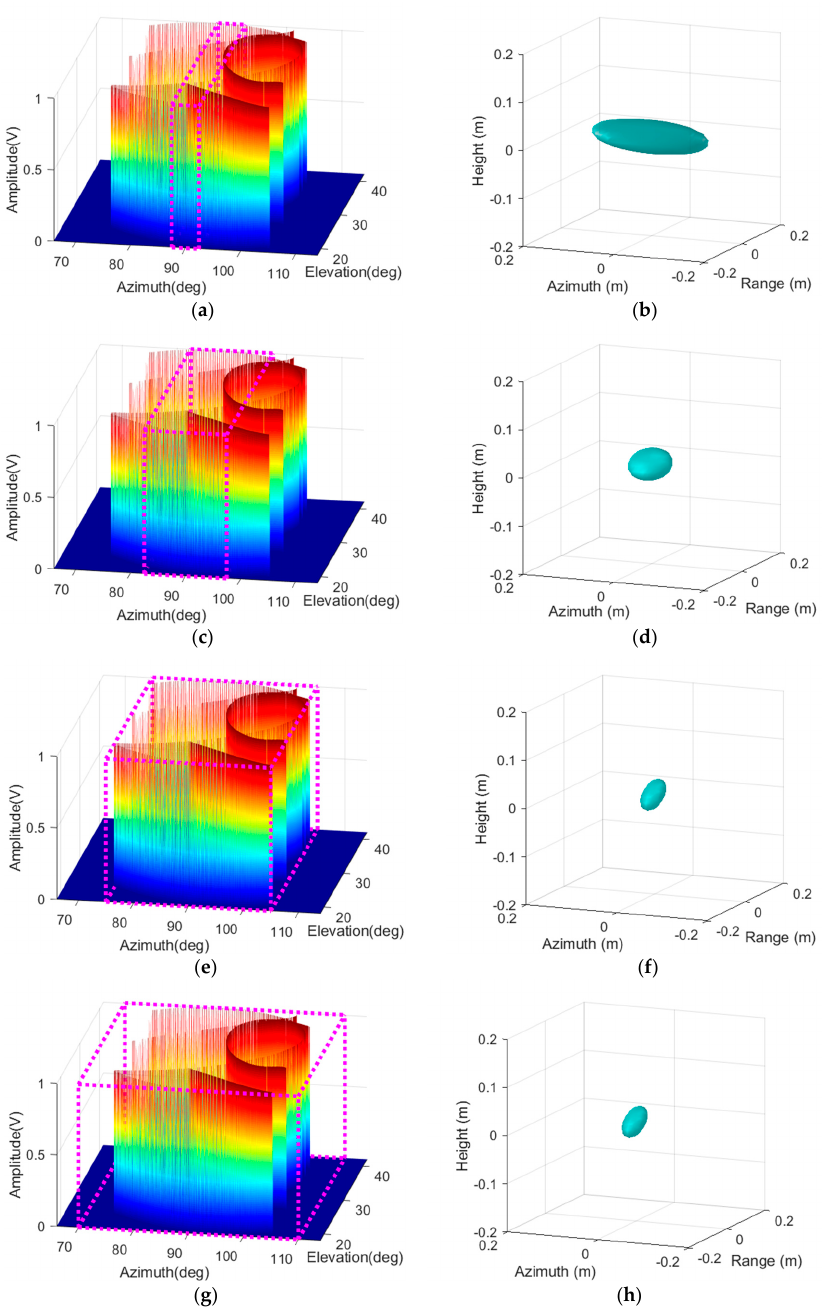
Figure 5. Target scattering amplitudes and 3-D imaging results with different azimuth aperture extents. ( a , c , e , g ) show target scattering amplitudes with azimuth aperture extent of 5, 15, 30 and 40°, respectively; ( b , d , f , h ) show 3-D imaging results with azimuth aperture extent of 5, 15, 30 and 40°, respectively.